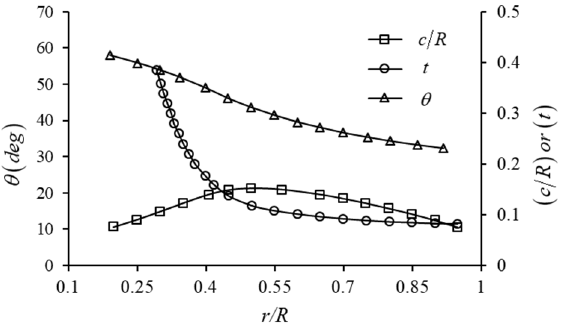
Figure 6. The regression of the trained BP-ANN surrogate model for 2D airfoil aerodynamics. ( a ) C d regression; ( b ) C L regression.